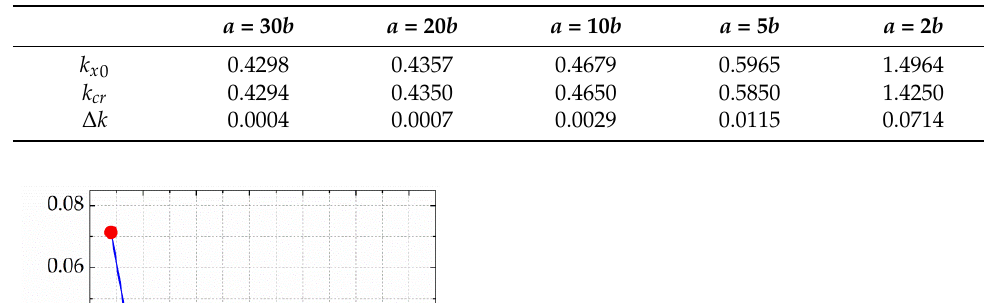
Table 1. Values of the buckling coefficients with the change of a / b .